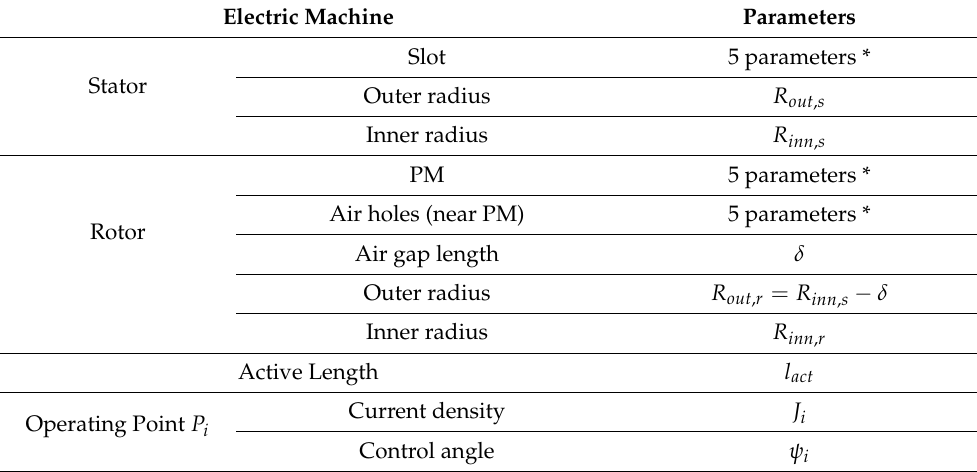
Figure 1. One pole of single-layer V-shaped IPMSM. Table 2. Geometric parameter of single-layer V-shaped IPMSM.